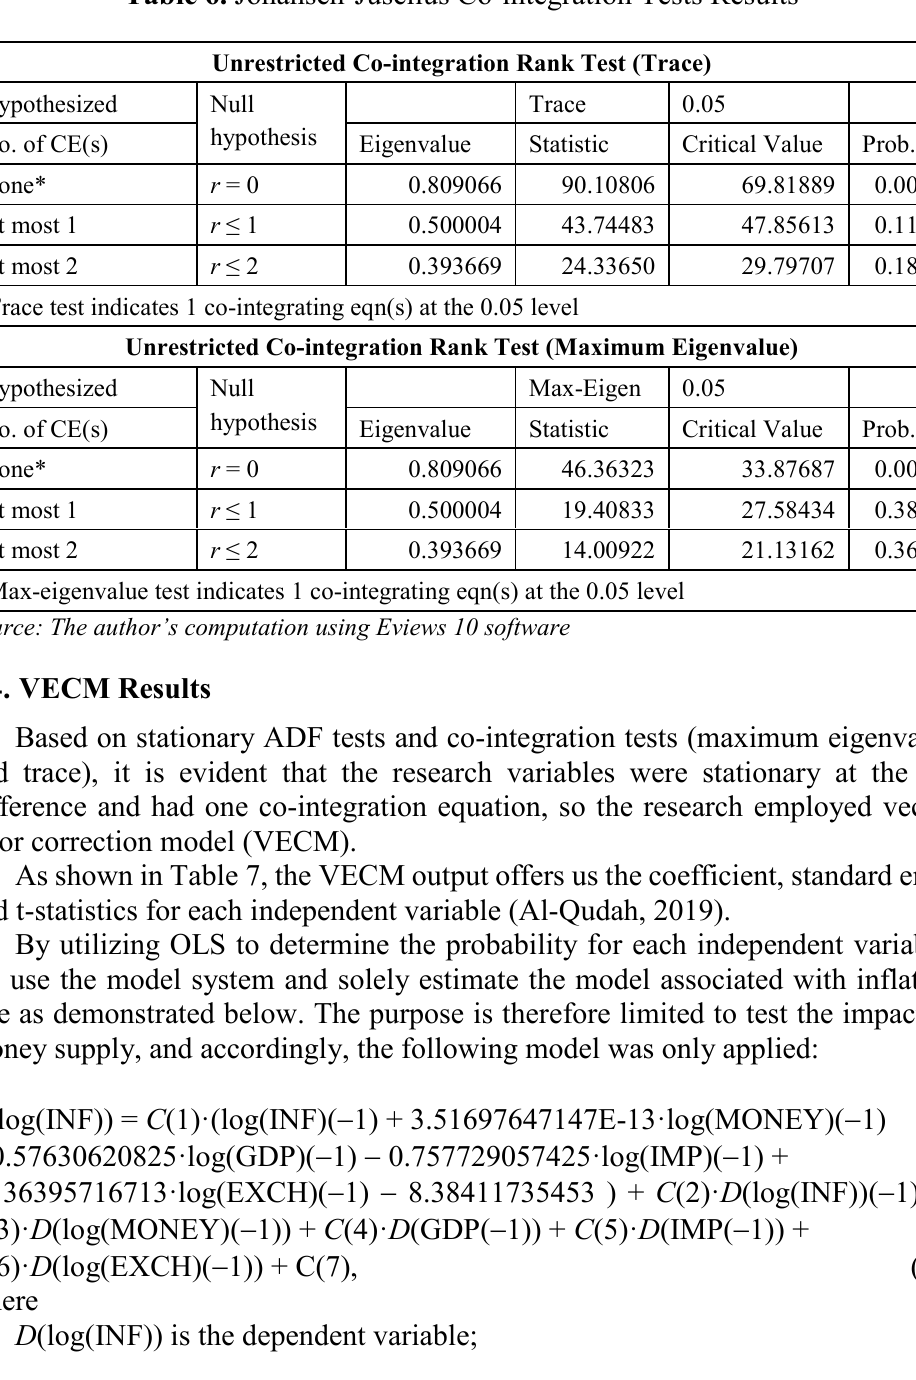
Table 6. Johansen-Juselius Co-integration Tests